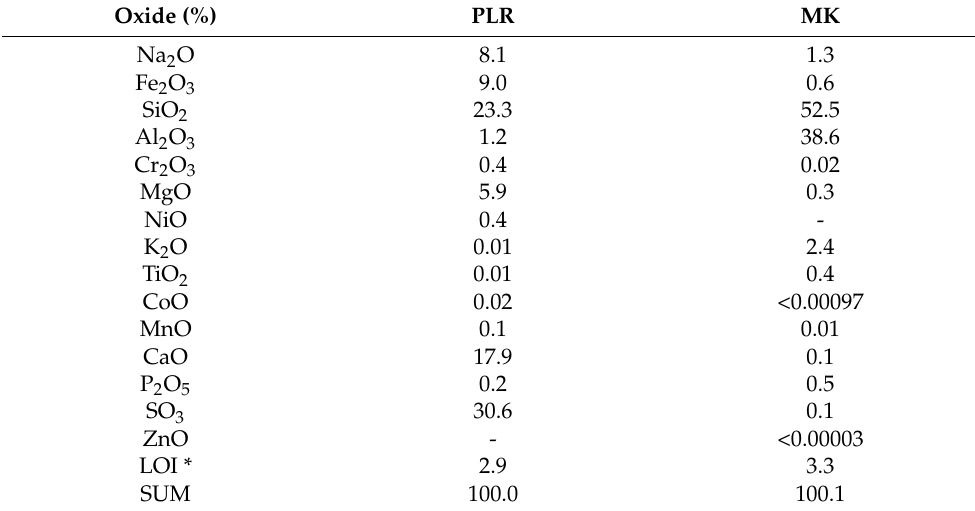
Table 2. Chemical composition (wt%) of raw materials.